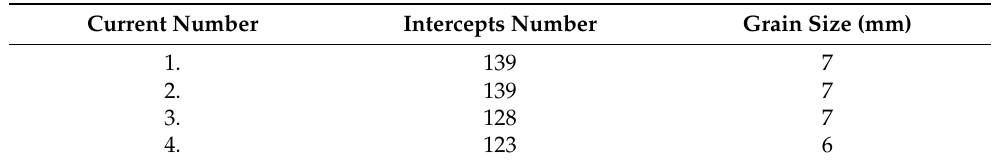
Table 8. The results were obtained after determining the austenitic grain index for the 25CrMo4 sample [1].